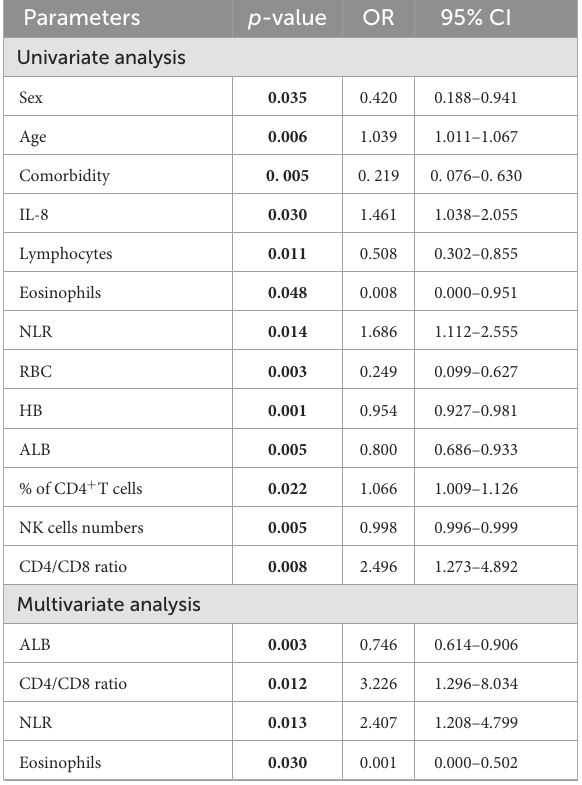
TABLE 6 Univariate and multivariate logistic regression analysis for COVID-19 patients.